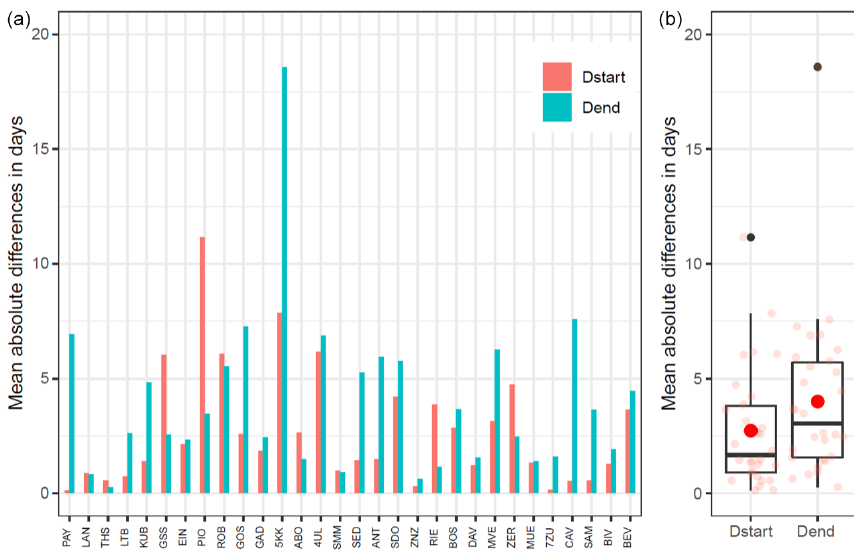
Figure 4. (a) Mean absolute differences in onset (Dstart) and disappearance (Dend) dates for all station pairs. The station pairs are ordered from left to right according to their elevation. (b) Variations of mean absolute differences of Dstart and Dend for all station pairs and available years. The light red dots mark the actual values, and the bold red dot indicates the mean.